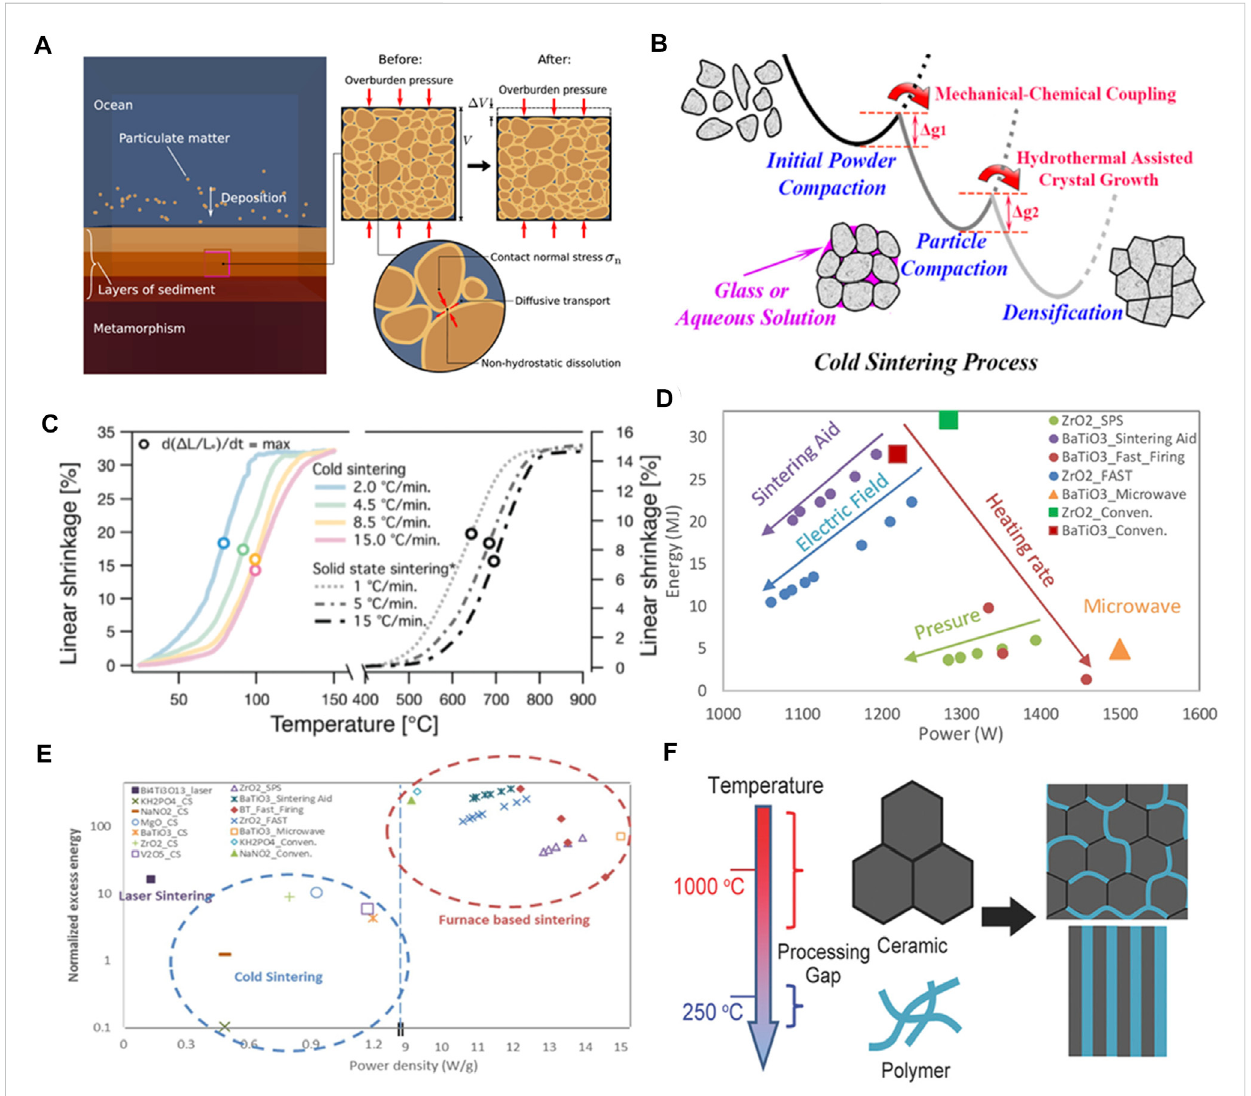
FIGURE 1 Geomimetics inspired cold sintering process (CSP). (A) The geology diagenesis in sedimentary basins (Gundersen et al., 2002). (B) The schematic of the cold sintering mechanism (Guo H et al., 2016). (C) The sample shrinkage difference between the CSP and solid-state sintering (Bang et al., 2020a). (D and E) Thecomparisonofenergydissipationsandconditionsfordifferentsinteringmethods(SohrabiBabaHeidaryetal.,2018). (F) Theco-sinteringability for ceramic-polymer composite designs at a low temperature (Guo et al., 2018). All reproduced with permission,